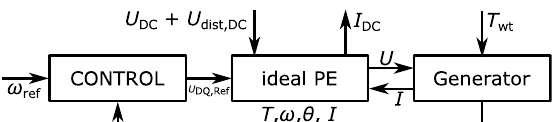
Figure 11. Simulation implemented in Matlab/Simulink using